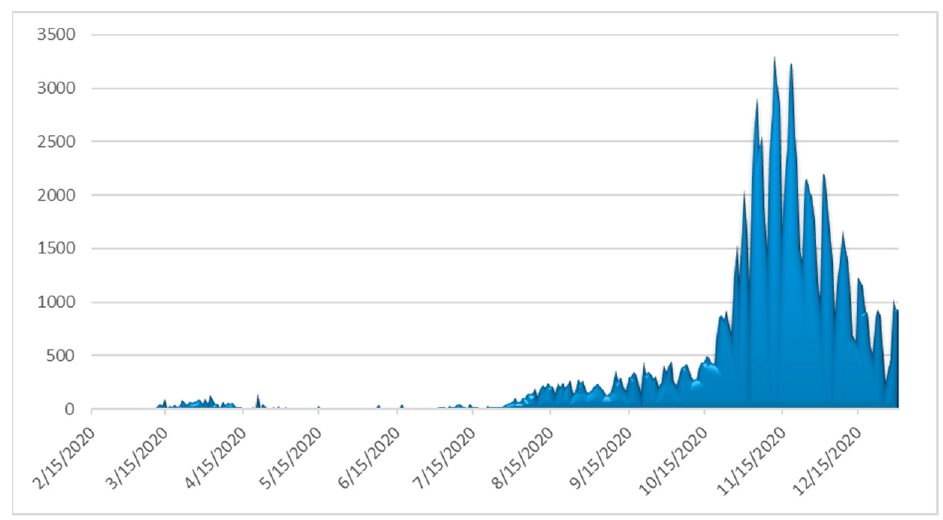
Figure 3. Daily number of laboratory-confirmed COVID-19 cases in Greece (data available from ECDC (https://www.ecdc.europa.eu/en/publications-data/covid-19-testing ; accessed on 2 March 2021) .